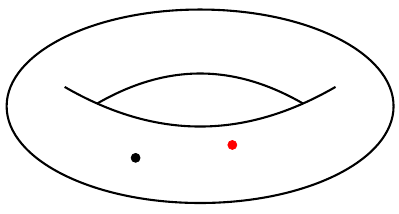
Figure 2 . The elliptic curve